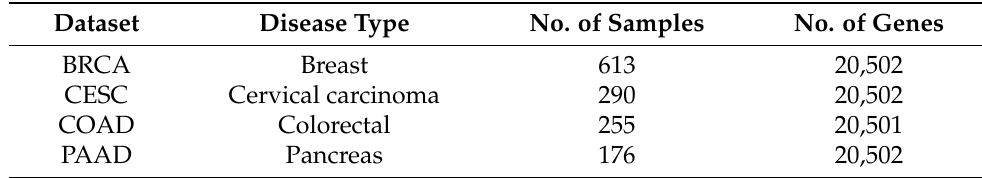
Figure 1. Flowchart of the learning method. Each level of the cascade consists of deep survival forests, which directly learn cancer prognosis prediction with multiple decision trees. All connected features will be optimized to obtain a more compact feature set and then transferred to the next level. Our model can use both labeled and unlabeled datasets. Deep survival forest can labels unlabeled data to augmented training datasets. Table 1. Four tumor experimental